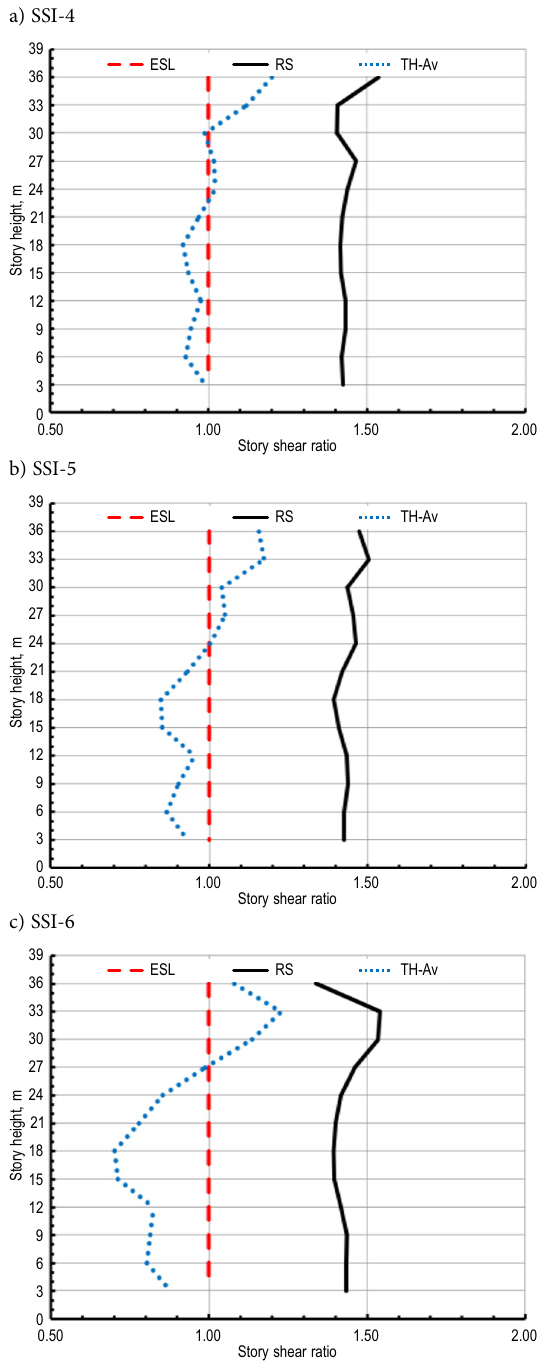
Fig. 15. Story shear force response of SSI model to that of NSSI model of 12-story